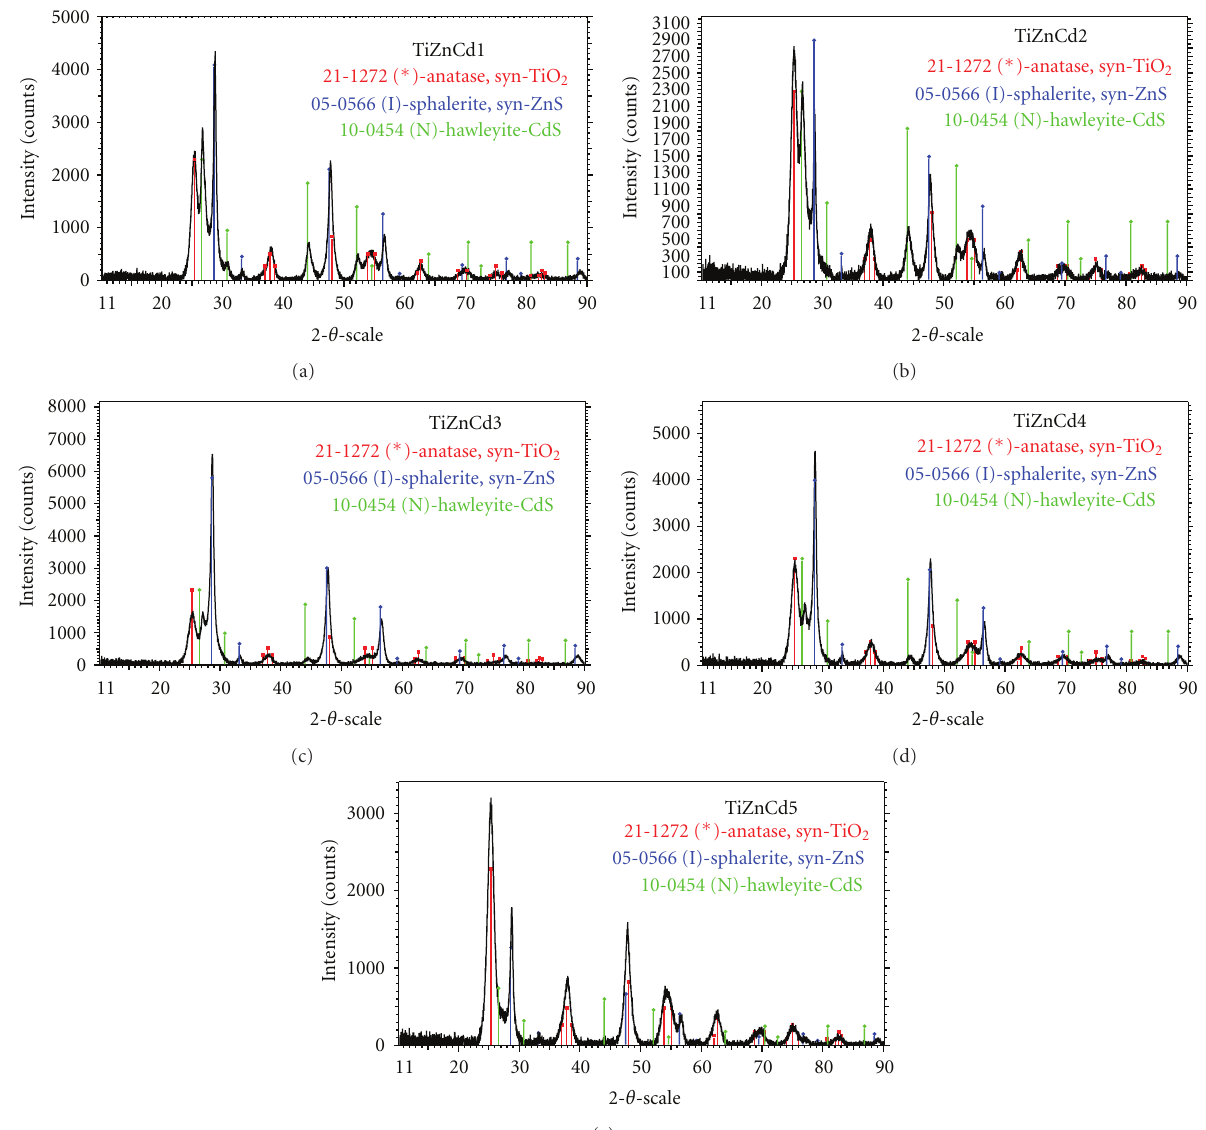
Figure 4: XRD patterns of sample (a) TiZnCd1, (b) TiZnCd2, (c) TiZnCd3, (d) TiZnCd4, and (e)